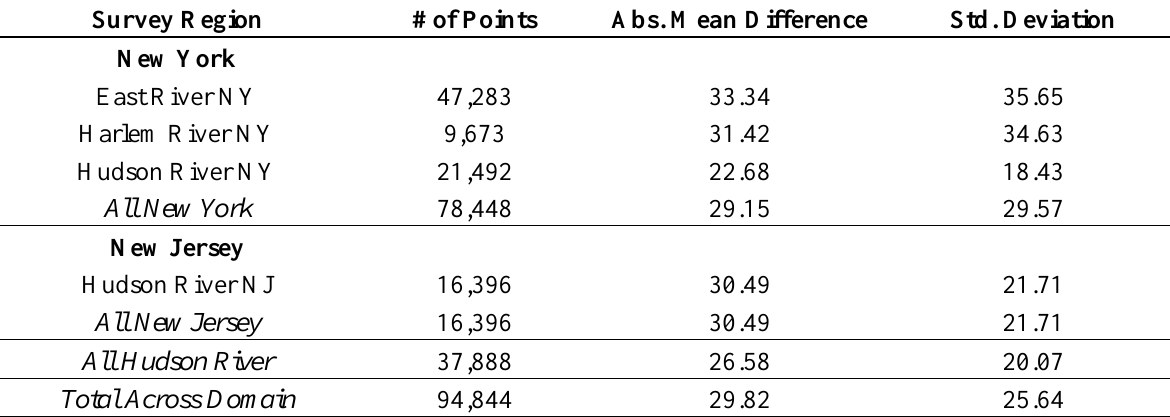
Table 2. The comparison of maximum horizontal extent of inundation in New York City between model-simulated and data-derived distance estimates by